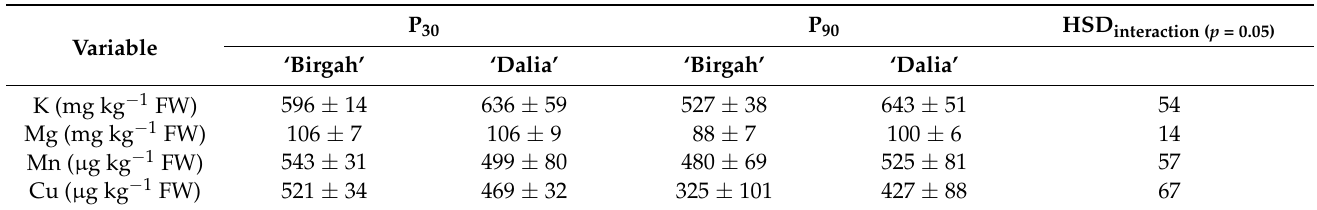
Table 4. Potassium, magnesium, manganese and copper concentrations in eggplants (mean ± standard deviation) as affected by ‘phosphorus level × cultivar’